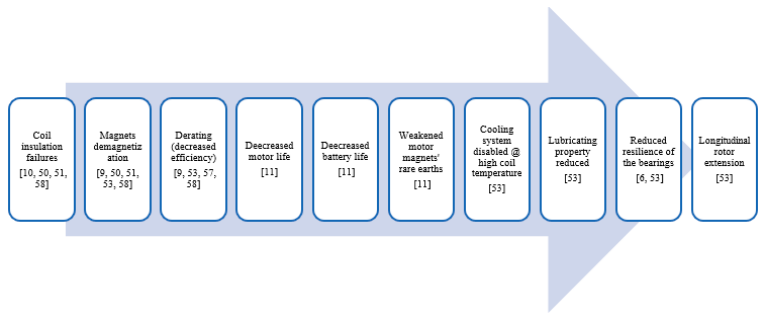
Figure 8. An overview of failures caused by uncontrolled temperature.